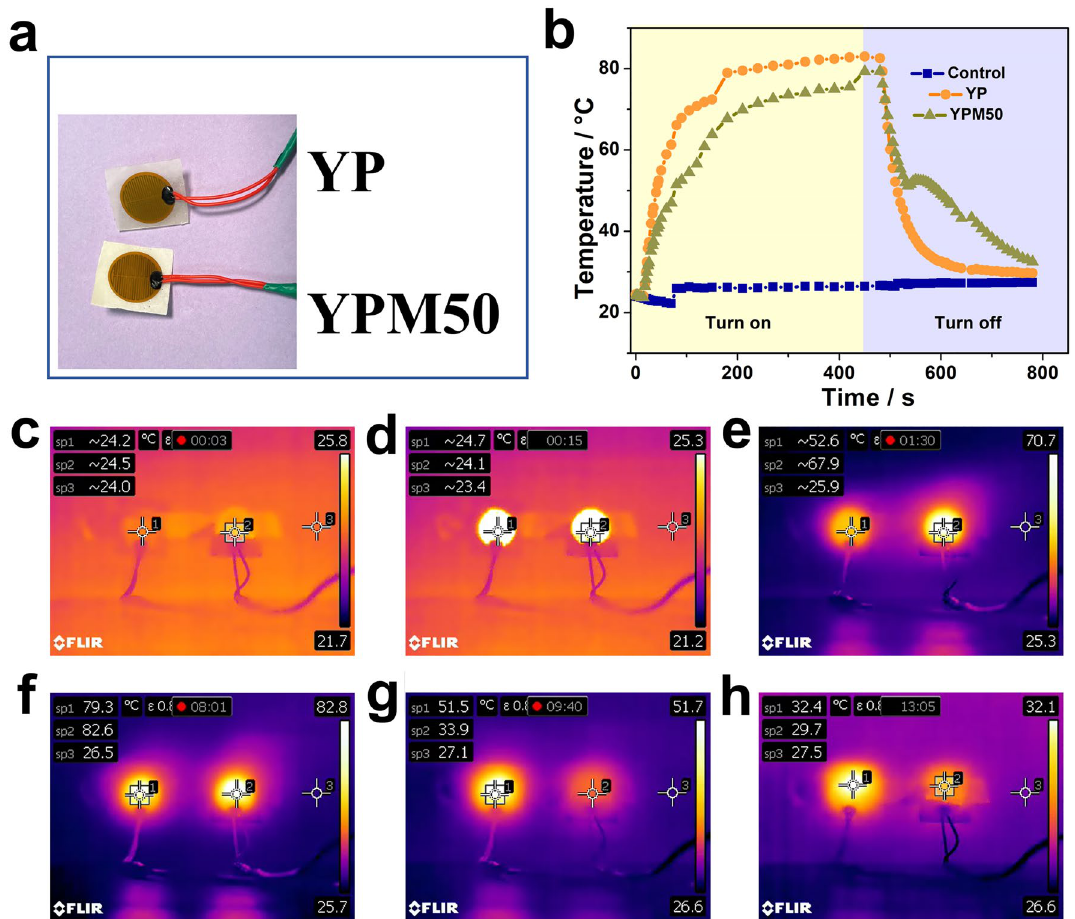
Figure 6. The ( a ) thermal management layer ( b ) temperature evolution curves of the samples during heating and cooling, Control sample was the ambient temperature; the infrared thermal imagines(sp1 is the temperature of PI-based heater with YPM50 film, sp2 is the temperature of PI-based heater with YP film, sp3 is the ambient temperature during testing) ( c ) under room temperature ( d ) at heaters turning on ( e ) at the rapid upward ( f ) at heaters turning off ( g ) at the rapid decline ( h ) after turning off 304